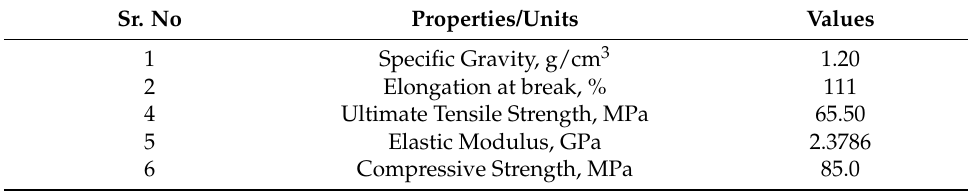
Table 2. Physical, Rheological, and Mechanical properties of